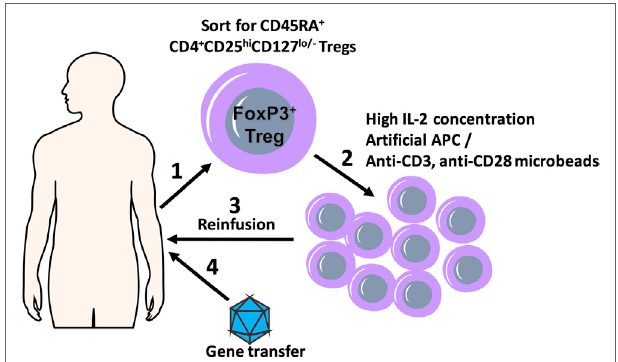
FiGURe 1 | A scheme detailing combination regulatory T cell (Treg) adoptive therapy with gene transfer for tolerization of immune responses. FoxP3 + Treg cells with polyclonal specificity are harvested from the patient (1) and ex vivo expanded in the presence of high IL-2 concentrations and artificial APC (aAPC) or anti-CD3, anti-CD28 microbeads using GMP protocols (2); expanded Tregs are transplanted back into the patient (3), which is followed shortly by gene transfer